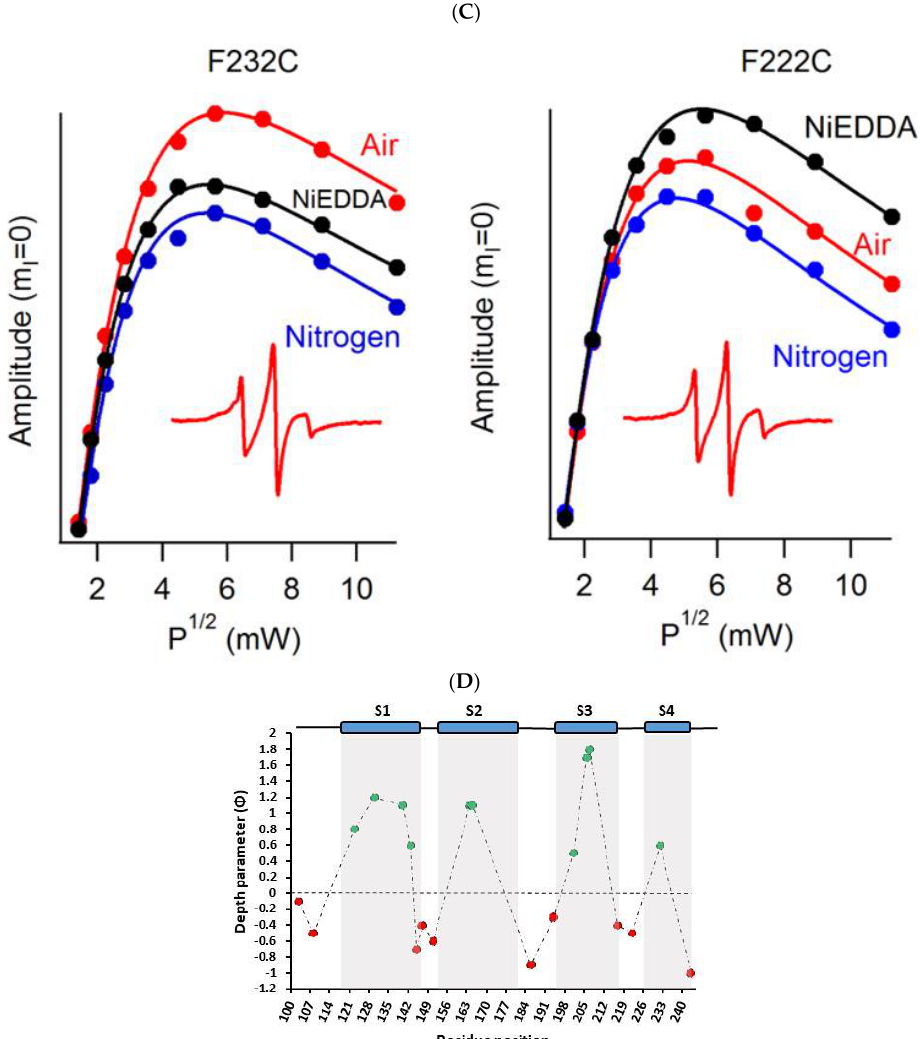
Figure 5. ( A ) The proposed topology of the Q1VSD sequence in lipid bilayers. The black arrows show the order of the amino acid residues in the protein sequence. The green and red circles represent spin-label sites buried inside and outside of the membrane bilayers respectively. ( B ) and ( C ) EPR power saturation curves from Q1VSD in 1-palmitoyl-2-oleoyl-phosphatidylcholine (POPC) / 1-palmitoyl-2-oleoyl-phosphatidylglycerol (POPG) lipid-bilayered vesicles at 295 K. Mutation F130C is on helix S1 and is a part of the transmembrane domain, while the Q147C site is at the linker between helix S1 and helix S2 at a site outside the lipid bilayer. Mutation F232C is on helix S4 and is a part of the transmembrane domain, while the F222C site is at the linker between helix S3 and helix S4 at a site outside the lipid bilayer. The inset spectra are the corresponding CW-EPR spectra for these sites. ( D ) Membrane depth parameter ( φ ) as a function of Q1VSD residue position in POPC / POPG lipid-bilayered vesicles at 295 K. (Adapted from [84] with permission).